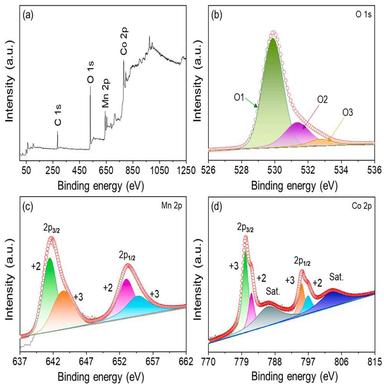
(a) XPS full spectrum of MnCo2O4-discs, and the high-resolution spectra of (b) O 1 s, (c) Mn 2p and (d) Co 2p.